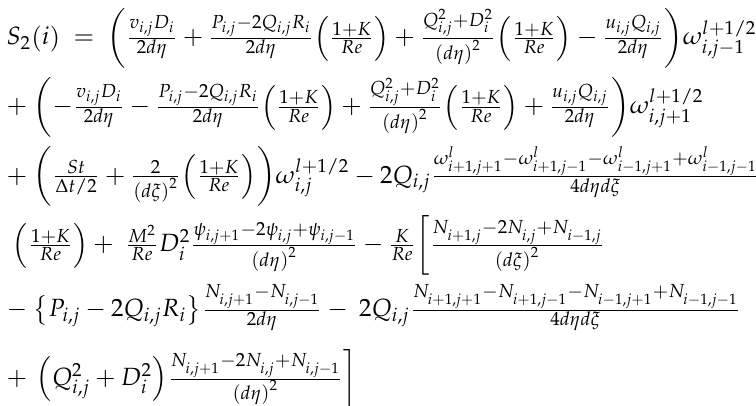
( a ) ( b ) Figure 3. The WSS distribution on varying magnetic parameter values, ( a ) on the upper wall, and ( b ) on the lower wall. The WSS on the upper wall in a pulsatile cycle at different times for (cid:1839) = 0 , 5 , 10 , and 15 with (cid:1837) = 0.6 , (cid:1845)(cid:1872) = 0.02 , and (cid:1844)(cid:1857) = 700 is shown in Figure 4. At (cid:1872) = 0 , the WSS tended to increase with increasing (cid:1839) and attained its peak value at (cid:1876) = 0 . The flow ac- celerated for 0 ≤ (cid:1872) ≤ 0.25 during the pulse cycle. At (cid:1872) = 0.25 , the WSS reached its ex- treme value at the maximum flow rate. During 0.25 < (cid:1872) < 0.75, the flow started to de- celerate, and the WSS decreased. The sign of the WSS changed at (cid:1872) = 0.75 , when the net flow rate was zero. The flow separation region was maximum for (cid:1839) = 0 , whereas it di- minished for (cid:1839) = 15 . The Hartmann number could be used to control the flow separa- tion region. The WSS on the upper wall in a pulsatile cycle at different times for (cid:1845)(cid:1872) = 0.02 , 0.04 , 0.06 , and 0.08 with (cid:1839) = 5 , (cid:1837) = 0.6 , and (cid:1844)(cid:1857) = 700 is shown in Figure 5. During 0 <